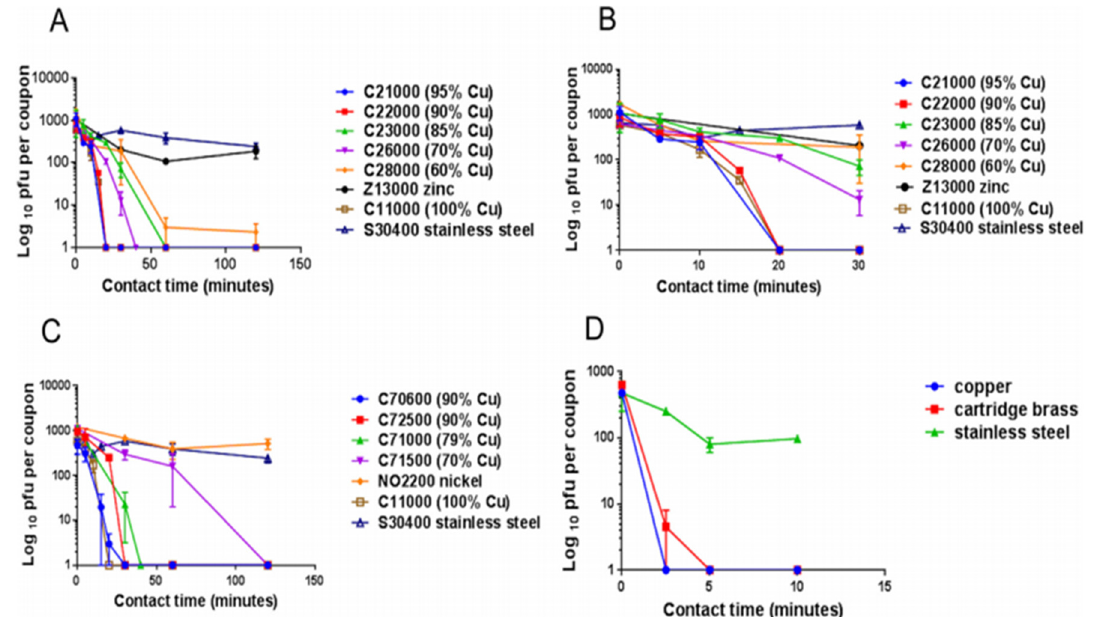
Figure 2. The panels describe the rapid contact-killing efficiency of various copper alloys (varies from 60% copper concentration to 100%) on human coronavirus-229E (HuCoV-229E), which causes the common cold. Initially, around 10 3 PFU HuCoV-229E (20 µL infected cell lysate) was applied on one sq. cm copper alloy coupon(s) with various copper concentrations, including stainless steel, nickel, and zinc (as control metals). ( A ) It was found that the coronavirus was inactivated less than 40 min on brass coupons and less than 120 min on copper-nickel alloy (containing less than 70% copper). Surprisingly the alloy with 70% copper showed quick antiviral activity than the alloy with 85% copper. ( B ) The observation showed an initial time lag on all alloys and metals, followed by rapid inactivation on copper coupons. The control metals stainless steel and nickel did not show any anti-coronavirus activity, except zinc, which showed little (significant only after 60 min, p = 0.046). ( C ) When the copper concentration was reduced to 70%, it took approximately 80 min more to inactivate all the viruses compared to one with 79% copper. ( D ) When the same inoculum was applied at 1 µL per sq. cm, the coupons inactivated the virus eight-time faster. The experiment showed that the concentration of copper and the amount of virus are significant factors in showing the antiviral activity. Adapted from Ref. [93]